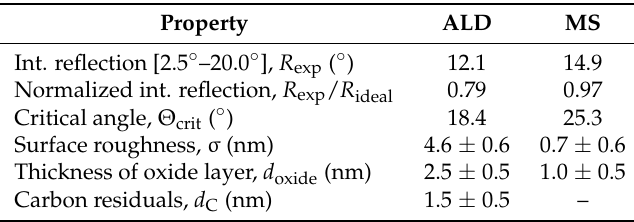
Figure 6. Comparison of experimental reflection data of sputtered and ALD Ru films in the soft X-ray and extreme UV (XUV) spectral range. Shown in red is the fit with the simulation model Ru + RuO 2 + C. In blue, the reflectivity without a surface oxide and ideal smooth interfaces is shown. Table 2. Comparison of the optical properties and simulation results for a 35 nm thick ALD and a 50 nm thick sputtered Ru layer from XUV reflectometry (XUVR) measurements.